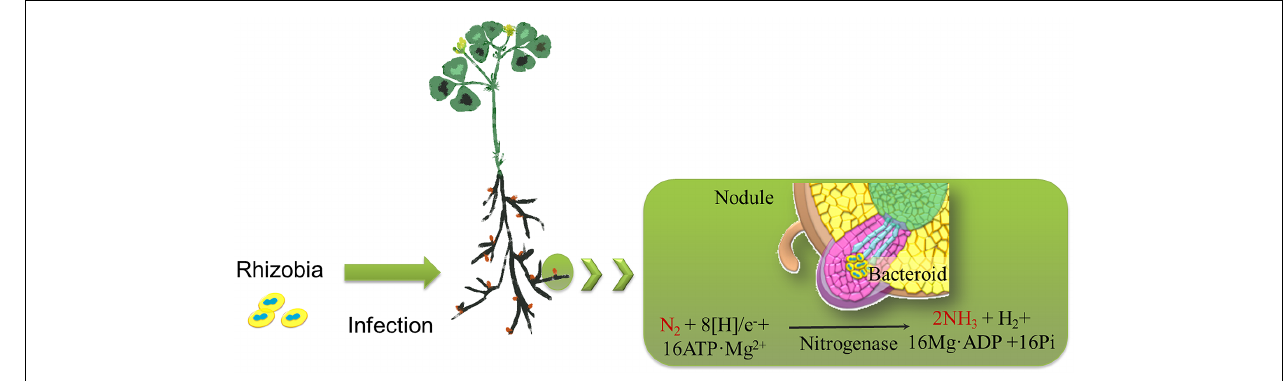
FIGURE 1 | Schematic drawing representing the nitrogen-fixing process associated with rhizobia. Rhizobia invade the roots of legumes (i.e., alfalfa) and form nodules. During the process of biological nitrogen fixation in